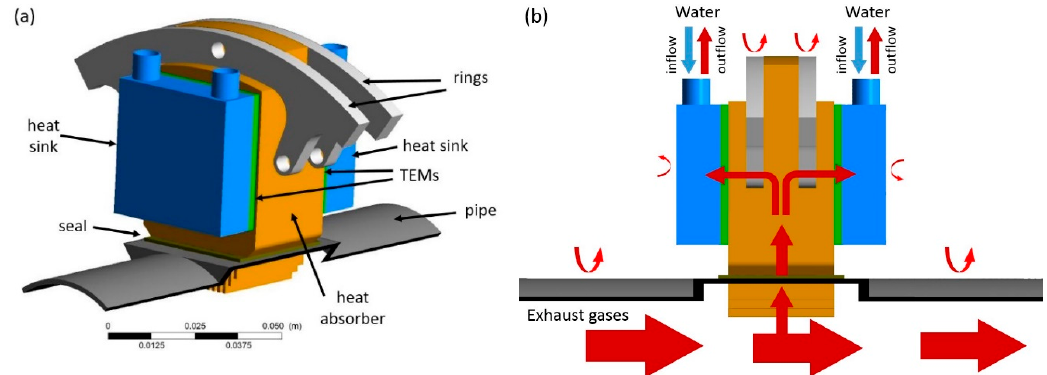
Figure 4. ( a ) Visualization of the domain applied in the simulations (solid parts only); ( b ) schematic drawing of the heat flow path.